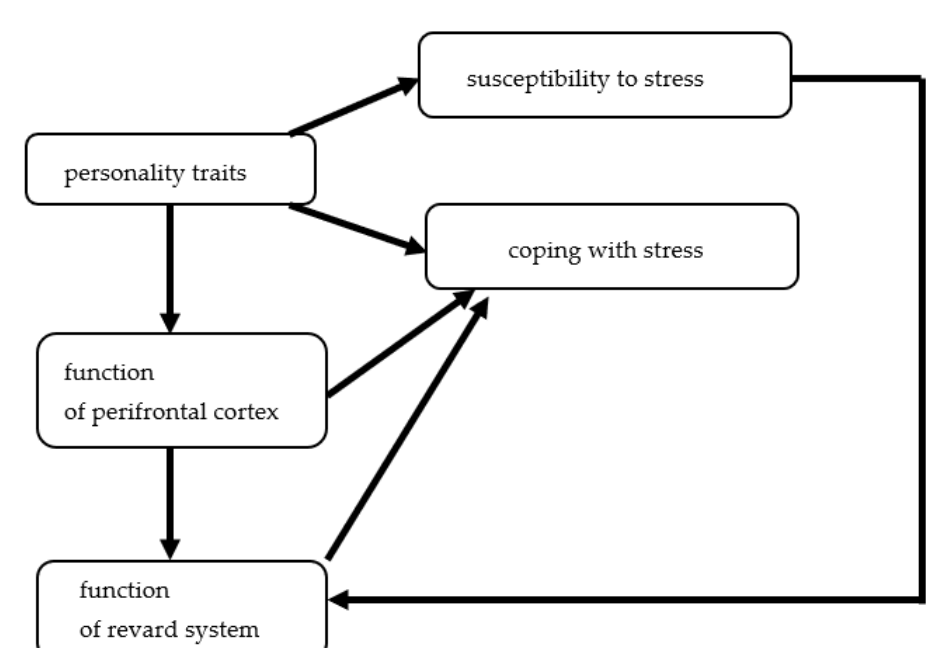
Figure 2. The determinants involved in emotional eating.